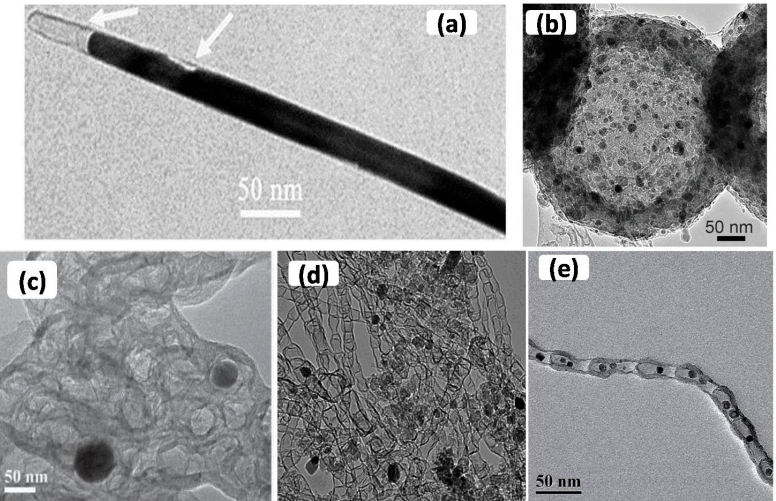
Figure 5. ( a ) TEM image of simple N-Fe/Fe3C/C nanrod with close-end graphite